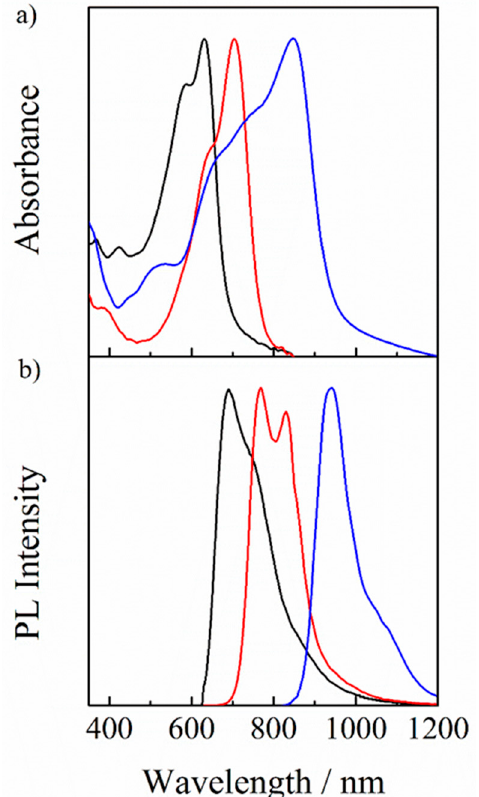
Figure 2. ( a ) Normalized UV-visible absorption and ( b ) PL spectra of PBDB-T (black lines), IT-M (red lines), and Y6 (blue lines) neat films excited at 550, 710, and 750 nm, respectively.